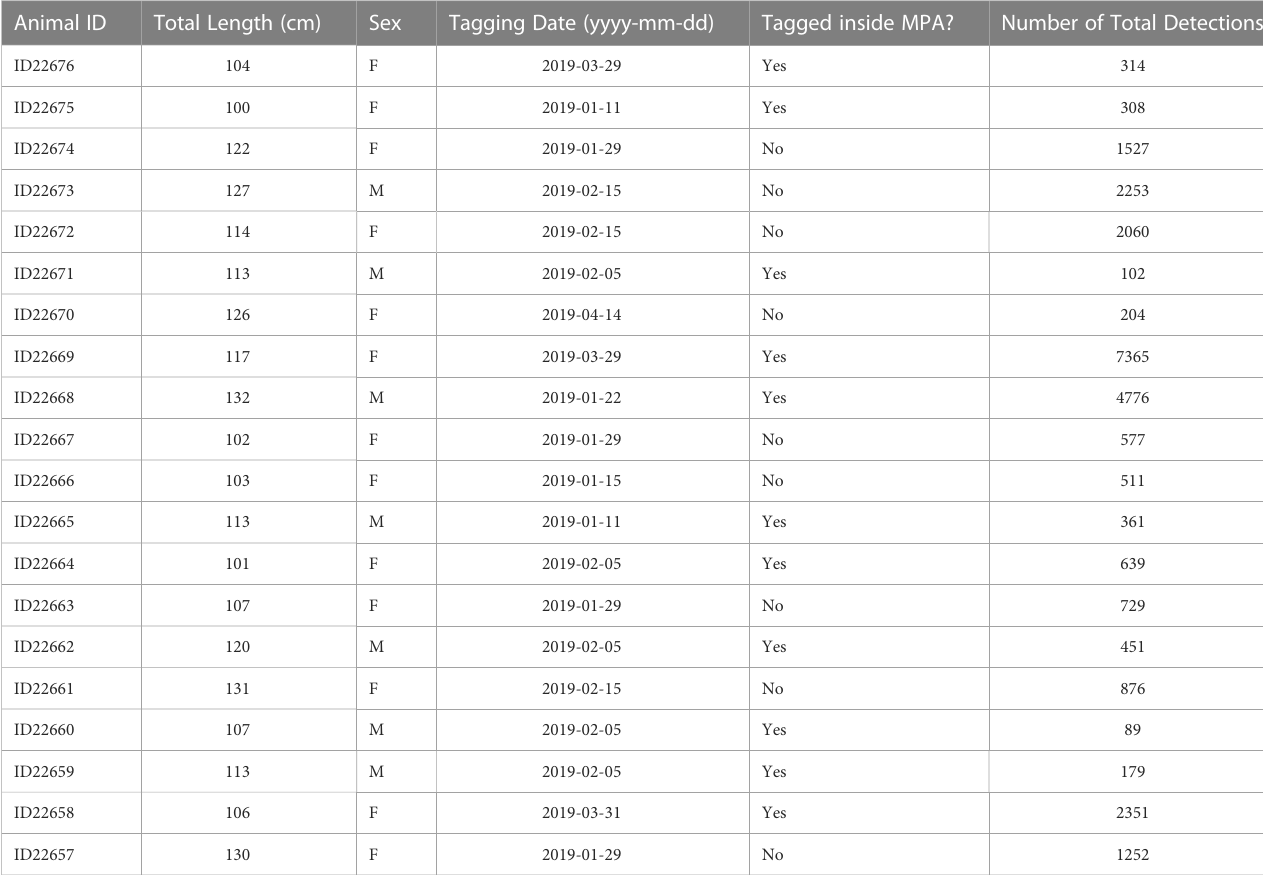
TABLE 1 Tagging metadata for juvenile smooth hammerheads tagged in and around the De Hoop MPA. Animal ID Total Length